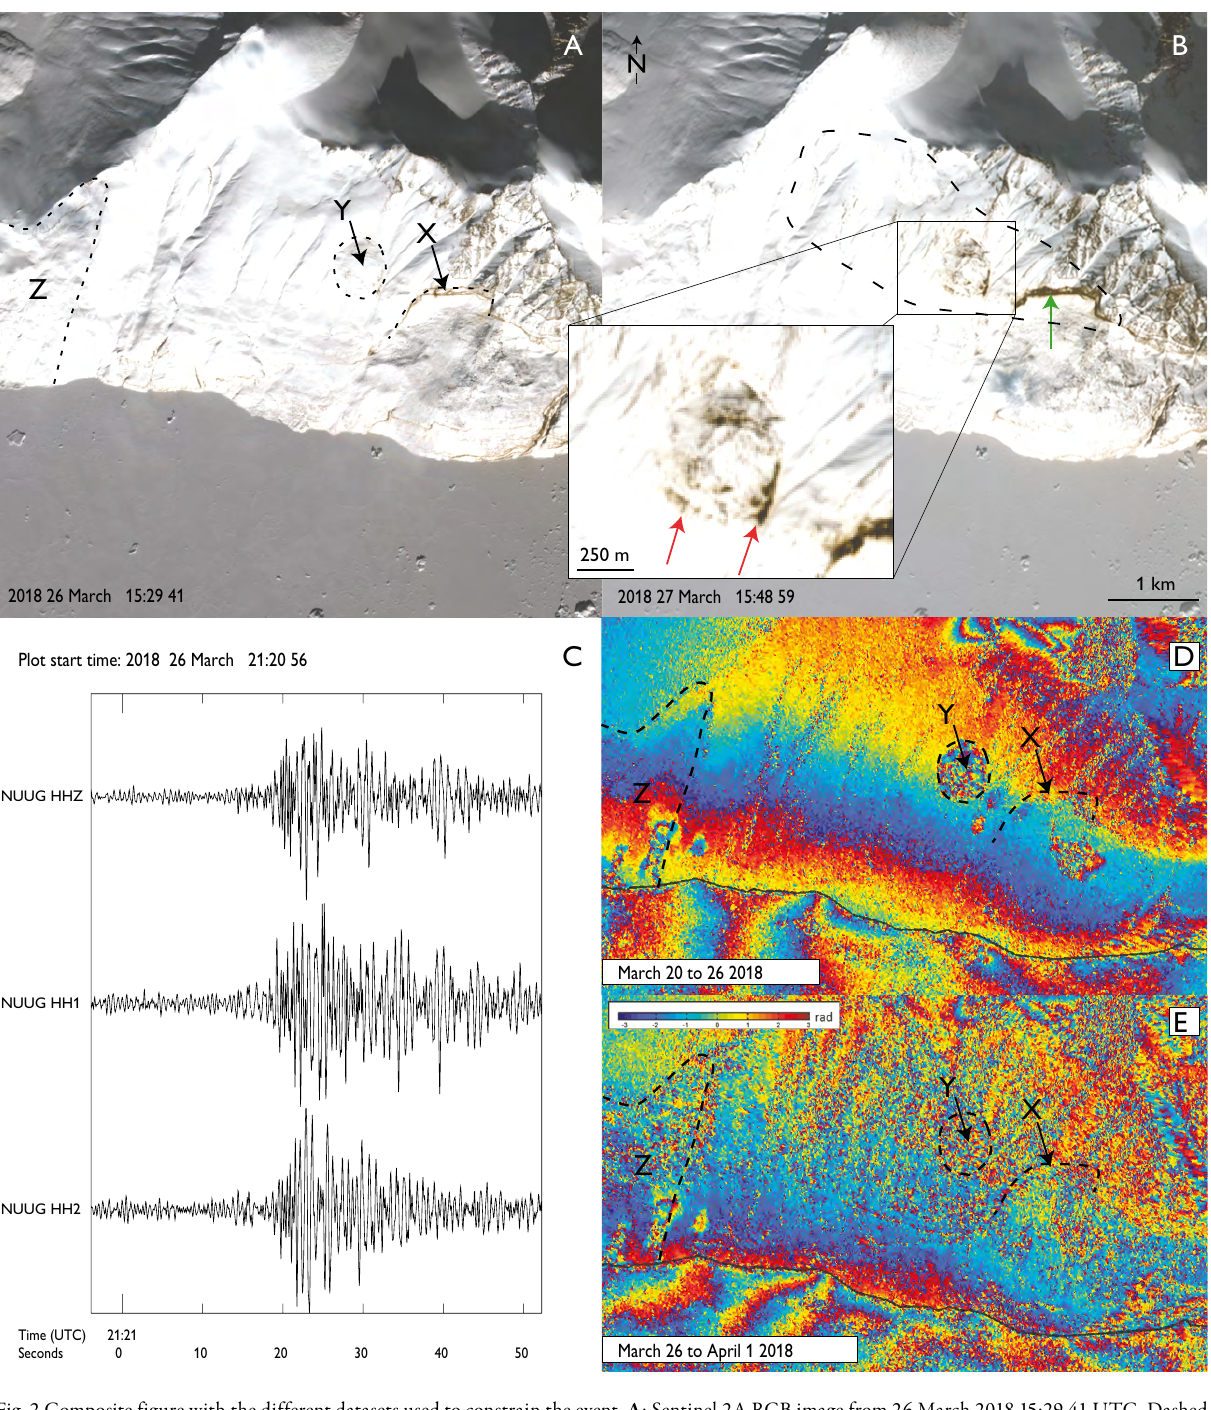
Fig. 2 Composite figure with the different datasets used to constrain the event. A : Sentinel-2A RGB image from 26 March 2018 15:29 41 UTC. Dashed line at X shows the scar of the 17 June 2017 landslide and Y shows the outline of the active area to the SW. Z indicates the position of a large older landslide with periodic activity in the toe. B : Sentinel-2B RGB image from 27 March 2018 15:48 59 UTC. Red arrows show rock fall at the unstable area Y and the green arrow shows rock fall at the back scarp of the Karrat 2017 event. The dotted black line shows the outline of the area affected by the event, as observed in the inset image. C : The 26 March 2018 21:21 UTC 1.9 ML seismic event as recorded on the Nuugaatsiaq seismograph (Fig. 1). D : Sentinel-1 differential interferogram from before the event, (20180320-20180326), the latter interferogram was acquired only hours prior to the event. X, Y and Z refer to the same areas in A. E : Sentinel-1 differential interferogram spanning the event from (20180326-20180401). X, Y and Z refer to the same areas in